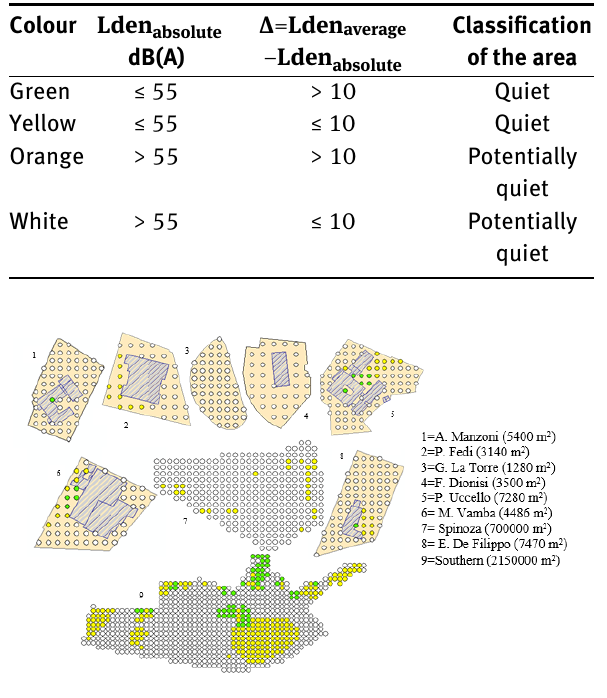
Figure 3: Results of the application of the rQUA method in the Man- zoni school in Florence (the darker grey colour is representative of the "white" category and the lighter grey of the "green"